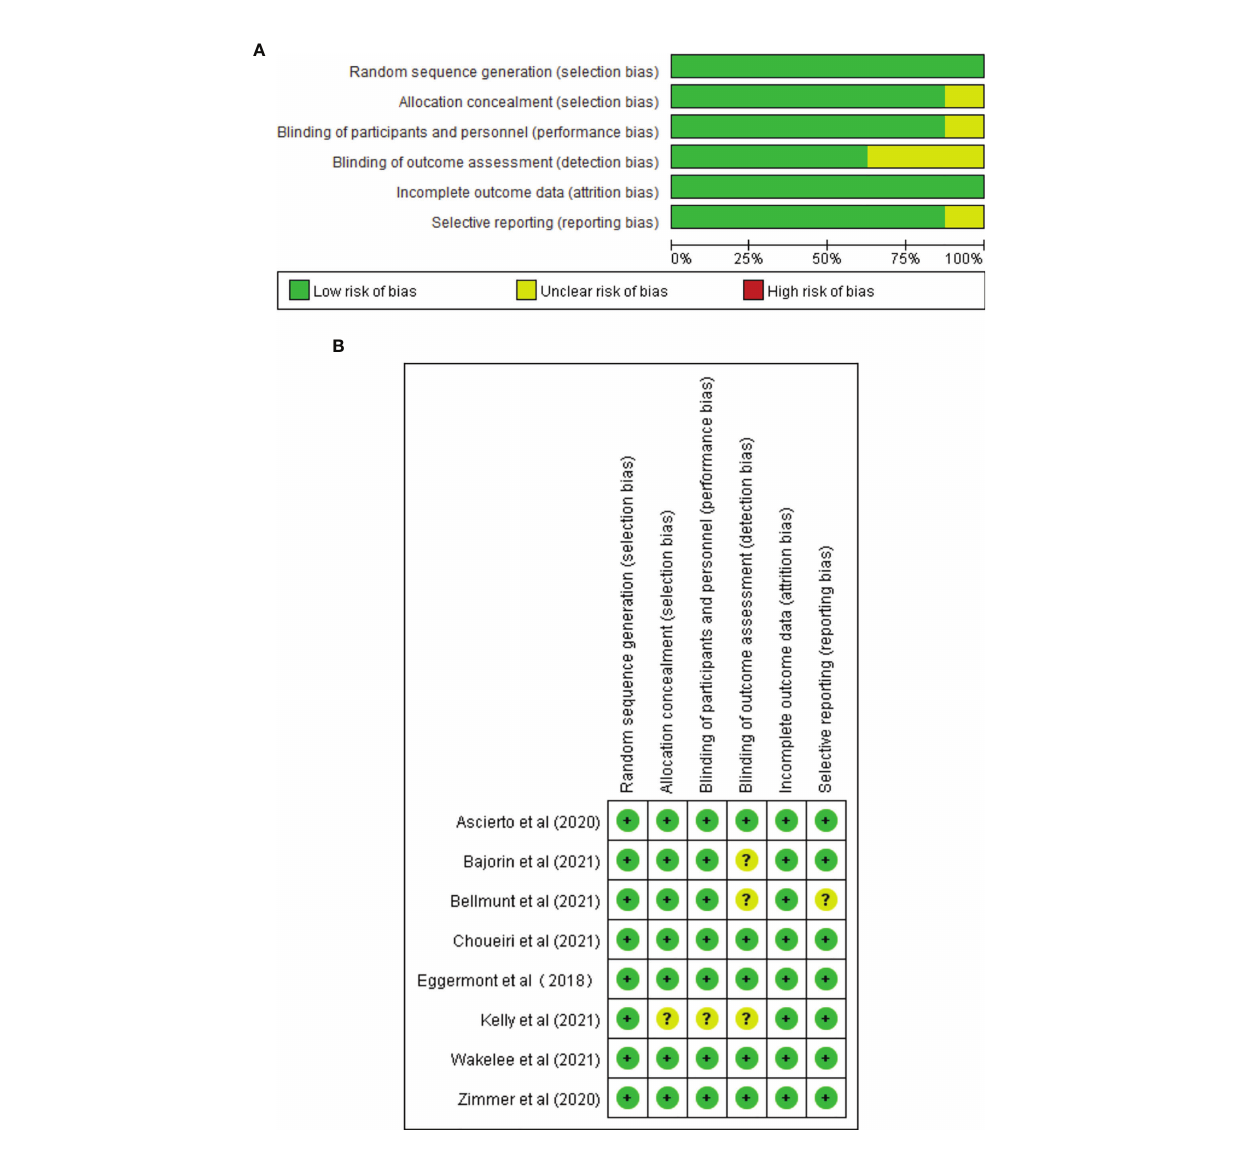
FIGURE 2 | Risk of bias assessment at the study level. (A) Risk of bias graph: review authors ’ judgment about each risk of bias item presented as percentages across all included full reported studies. (B) Risk of bias summary: review authors ’ judgment about each risk of bias item for each included